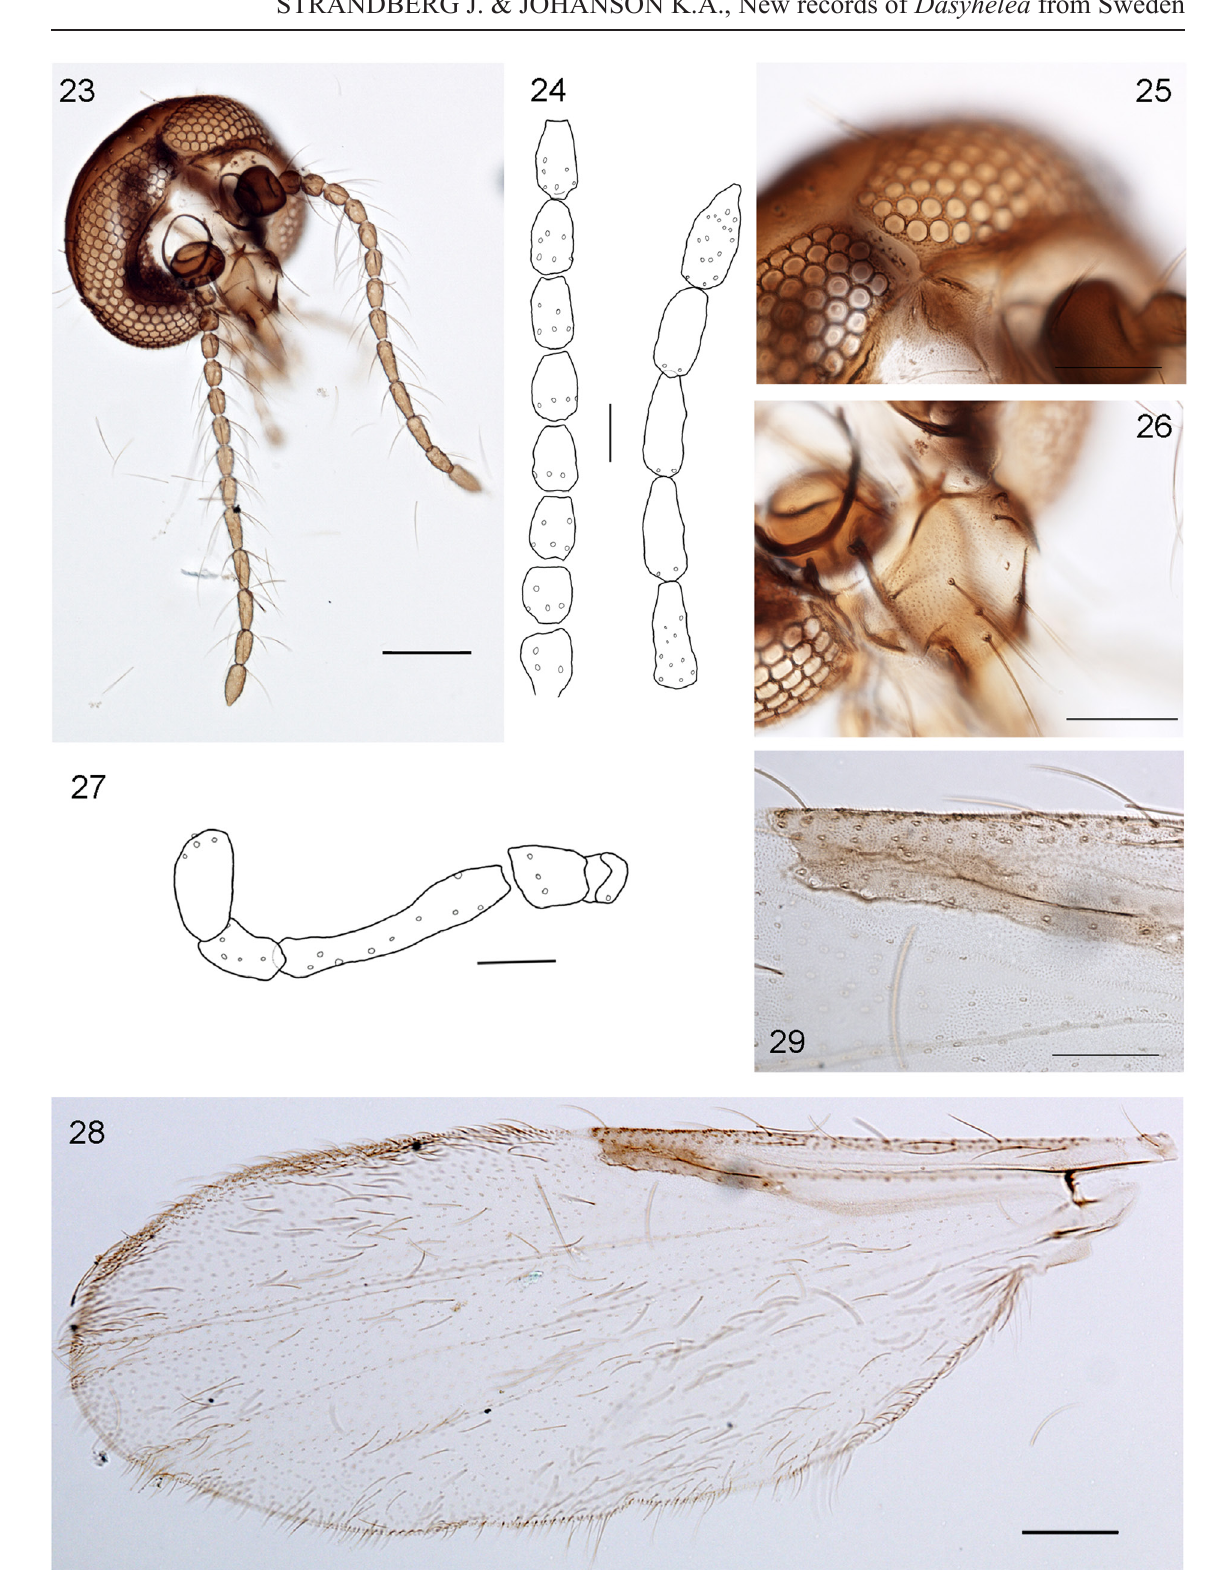
Figs 23–29. Dasyhelea gothlandica sp. nov., paratype, ♀. 23 . Head. 24 . Flagellomeres. 25 . Frontal sclerite. 26 . Clypeus. 27 . Palp. 28 . Wing. 29 . First and second radial cell of wing. Scale bars: 23, 28 = 100 µm; 25–26, 29 = 50 µm; 24, 27 = 25